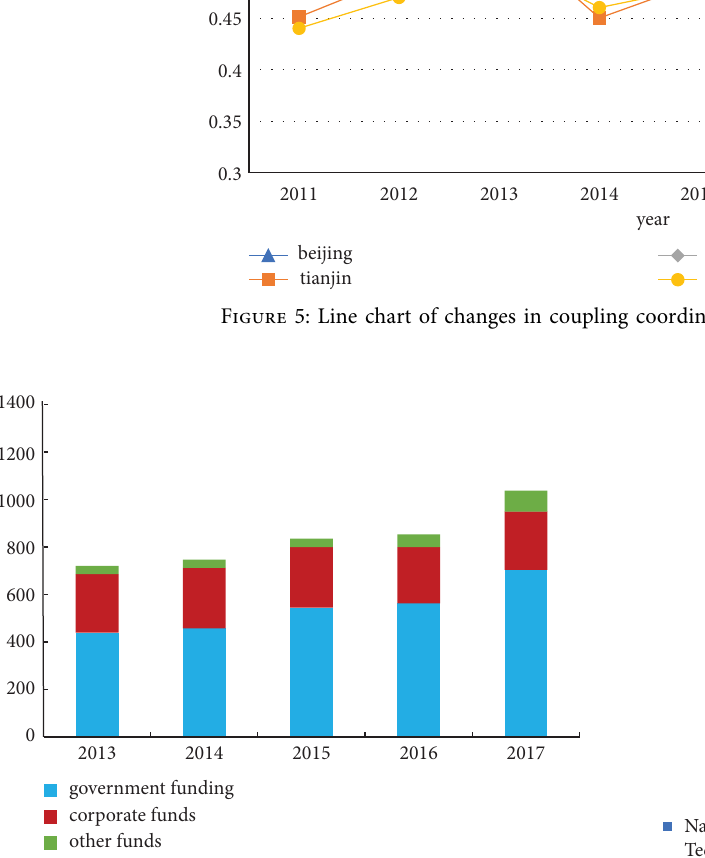
Figure 6: Sources of science and technology funding in Chinese universities from 2013 to